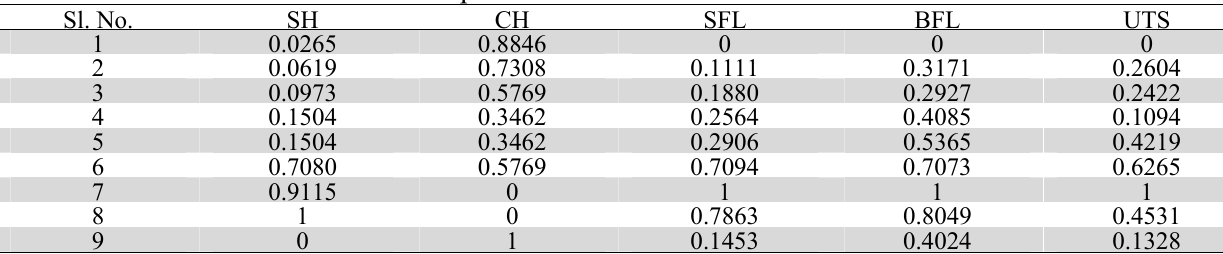
Normalized decision matrix for example 1 Sl. No.